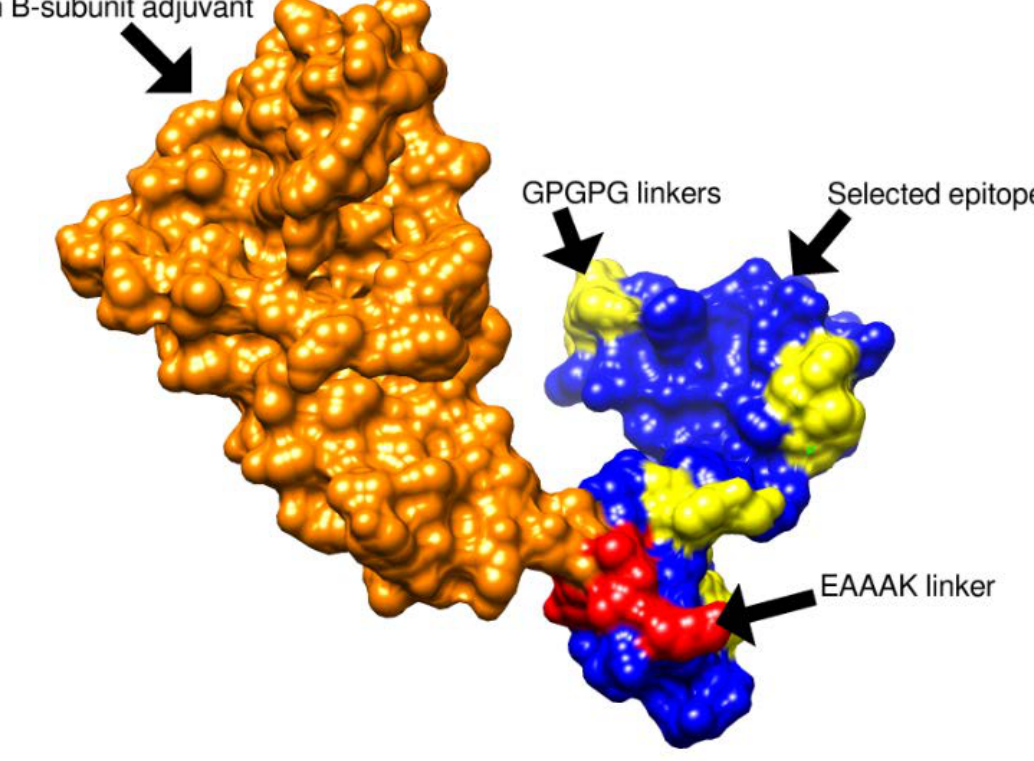
Figure 5. The 3D structure of multi-epitopes vaccine. Each segment is properly labeled in the fig- ure.